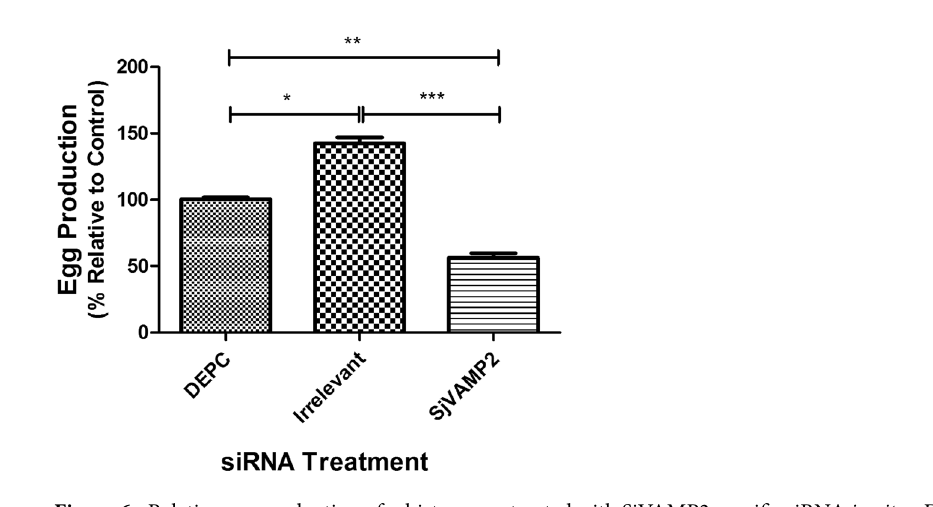
Figure 6. Relative egg production of schistosomes treated with SjVAMP2 specific siRNA in vitro . Data were compared with the DEPC-treated groups from three separate experiments. P-values were calculated using t-tests to compare the difference between the RNAi and control groups ( * P < 0.05, ** P < 0.01, *** P < 0.001).